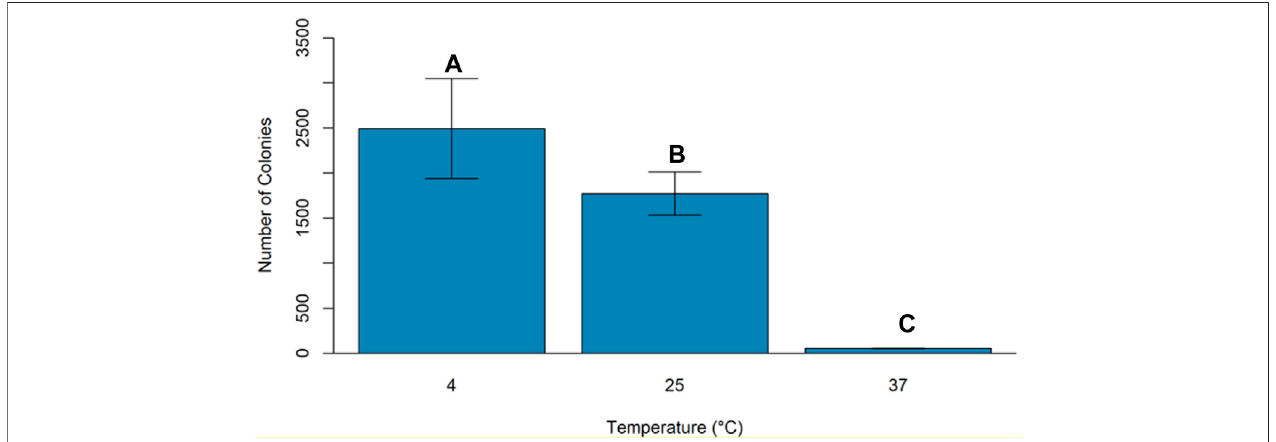
FIGURE 7 | Effect of incubation temperature on DNA delivery of COOH-CDs into E. coli cells.